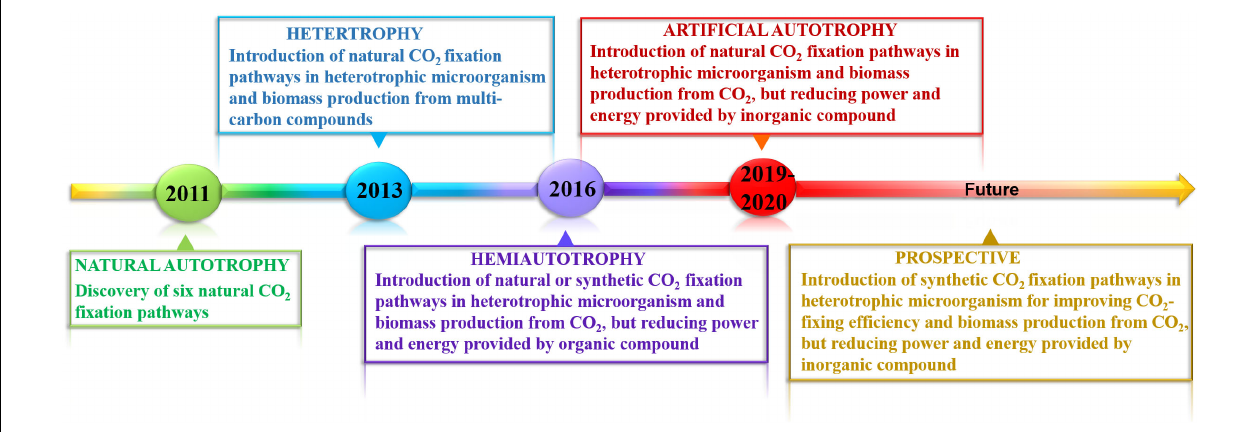
FIGURE 1 | Milestone in developing artificial autotrophy in the last decade. Until 2011, six naturally occurring CO 2 fixation pathways have been identified, some of which were introduced into heterotrophic microorganisms. However, all of biomass was derived from additional multi-carbon compounds, such as glucose. The strong advances in synthetic biology enable the engineering of synthetic CO 2 fixation pathways for improving carbon assimilation efficiency. Since 2016, hemiautotrophy has been successfully constructed by integrating natural or synthetic CO 2 fixation pathways in heterotrophic hosts using organic compound as reducing power and energy source, in which biomass was completely derived from CO 2 . In 2019 and 2020, the conversion of heterotrophy to fully autotrophy was realized though integration of natural CO 2 fixation pathways to support cell growth and inorganic compound’s oxidation to provide reducing power and